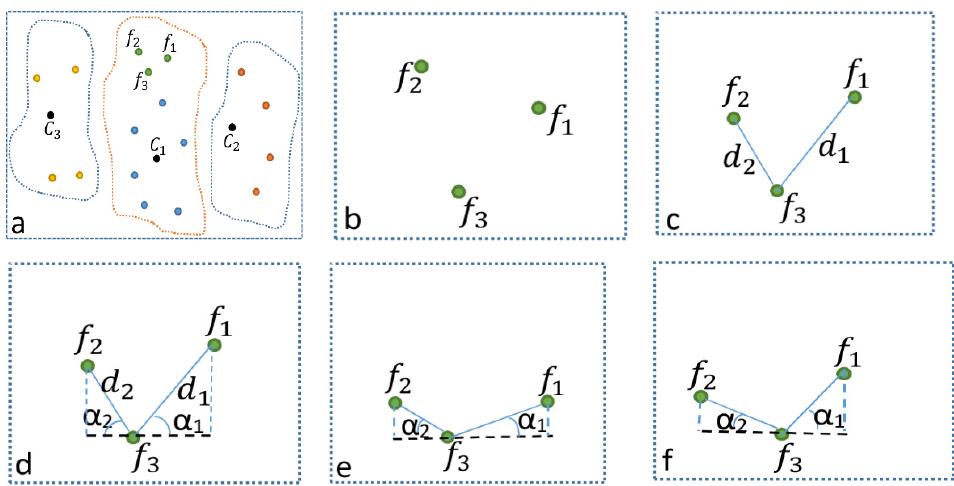
Figure 5. The possible relationship between those features that are supposed to be moved from one segmentation to others. ( a ) illustrates three segments with their centroids; ( b ) shows that all three features are independent based on Equation (10); ( c ) presents, feature f 3 has relationship with features ( f 1 and f 2 ); ( d ) shows that all three features ( f 1 , f 2 , and f 3 ) have relationships and the connection is evaluated based on angle ( α > 45 ◦ ), (see Equation (11)); ( e ) illustrates that all three features ( f 1 , f 2 , and f 3 ) have relationships and the connection is evaluated based on angle ( α < 45 ◦ ), (see Equation (12)); ( f ) shows a condition where the angle ( α ) can be greater than or less and equal to 45 ° , (see Equation (13)).